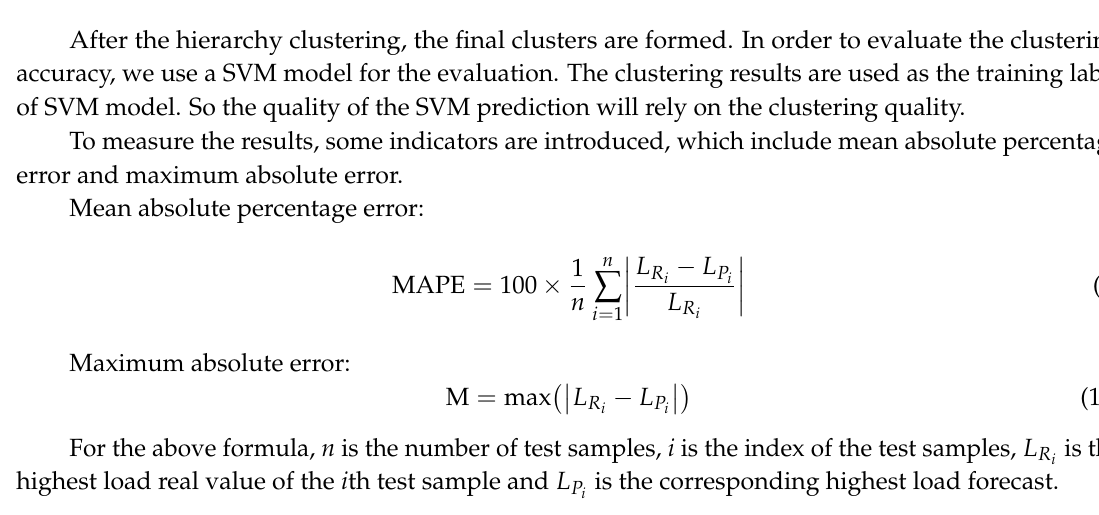
Figure 3. The experimental procedure.